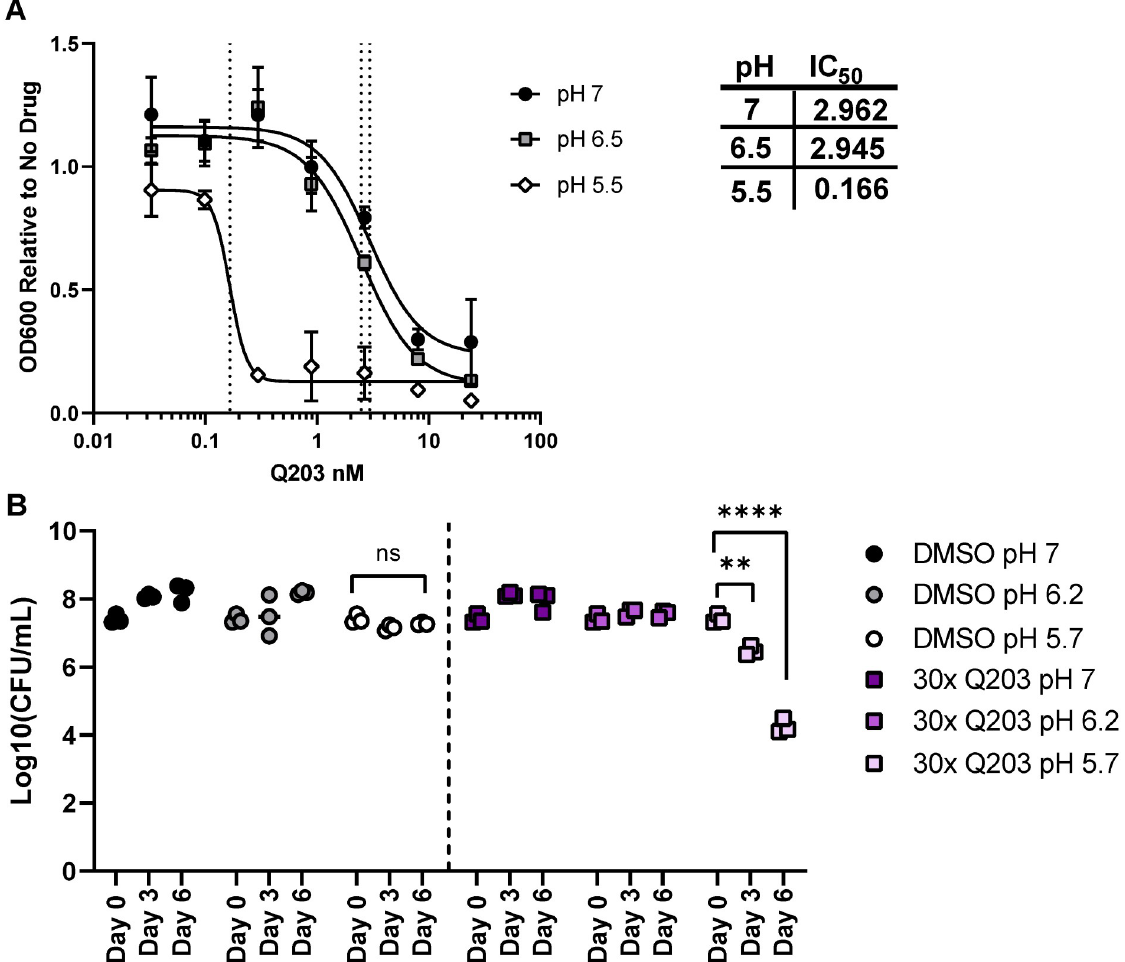
Fig 5. Low pH increases the potency of Q203. A) IC50 curves of H37Rv treated with Q203 at pH 7.0, pH 6.5 and pH 5.5 for 6 days in agitated culture. IC50 values for Q203 (nM) at each pH shown in the table. OD600 values are represented as relative to the no drug conditions because H37Rv growth is attenuated at pH 5.5. B) Day 0, 3, 6 CFU of H37Rv grown in agitated culture over 6 days at pH 7.0, 6.2, and pH 5.7 in the presence of 30x MIC Q203 (90 nM) or vehicle control (DMSO). Day 0 CFU timepoint is shared across all groups from DMSO pH 7 condition. Analysis was performed using a one-way ANOVA with Tukey post-test. �� p-value < 0.01, ���� p-value < 0.0001. Data depict single experiments that are representative of at least 3 independent